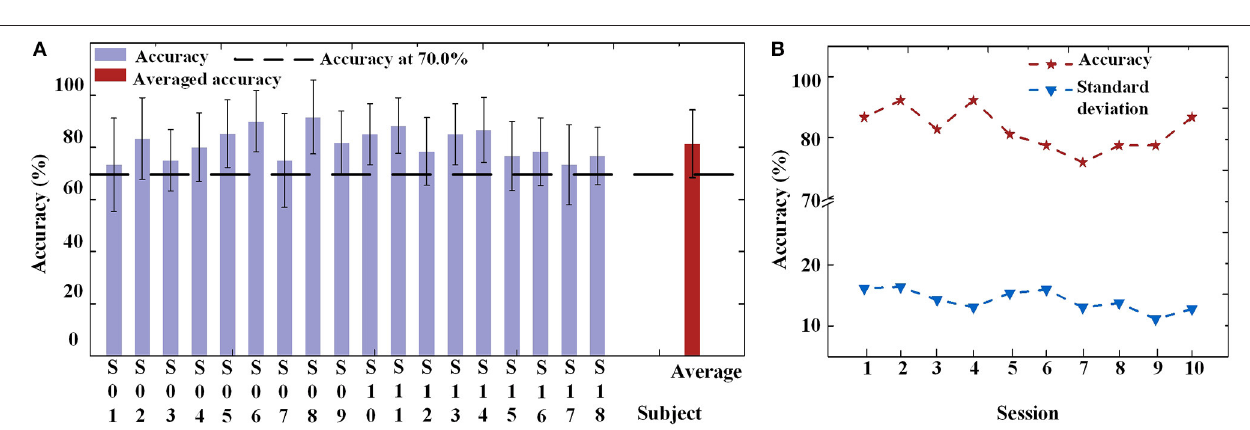
87.90 ± 11.65 and 88.34 ± 10.67%. The result of the